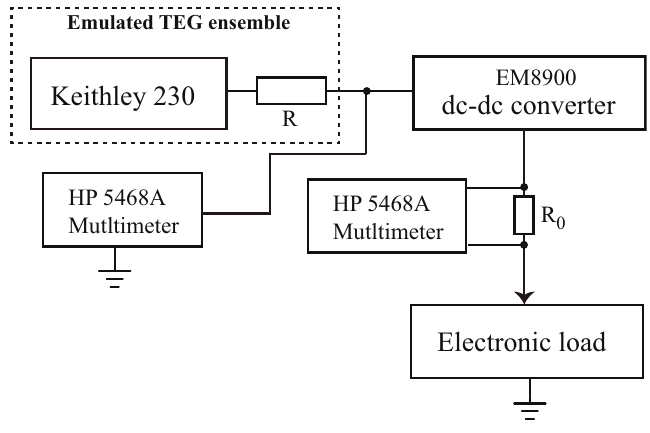
Figure 7. Proof-of-concept measurement set-up.